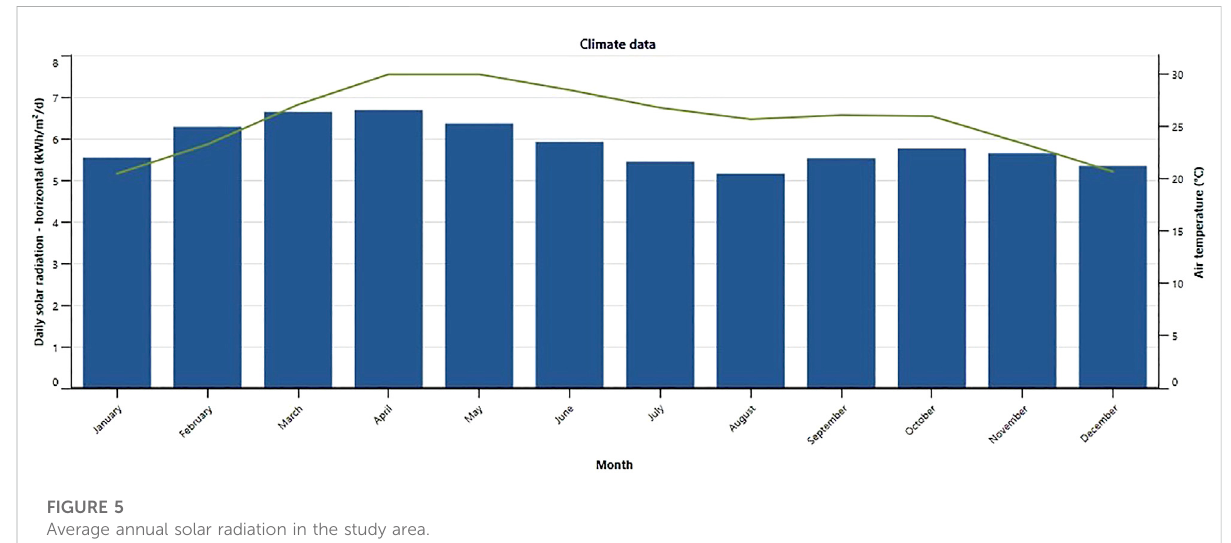
FIGURE 5 Average annual solar radiation in the study area.